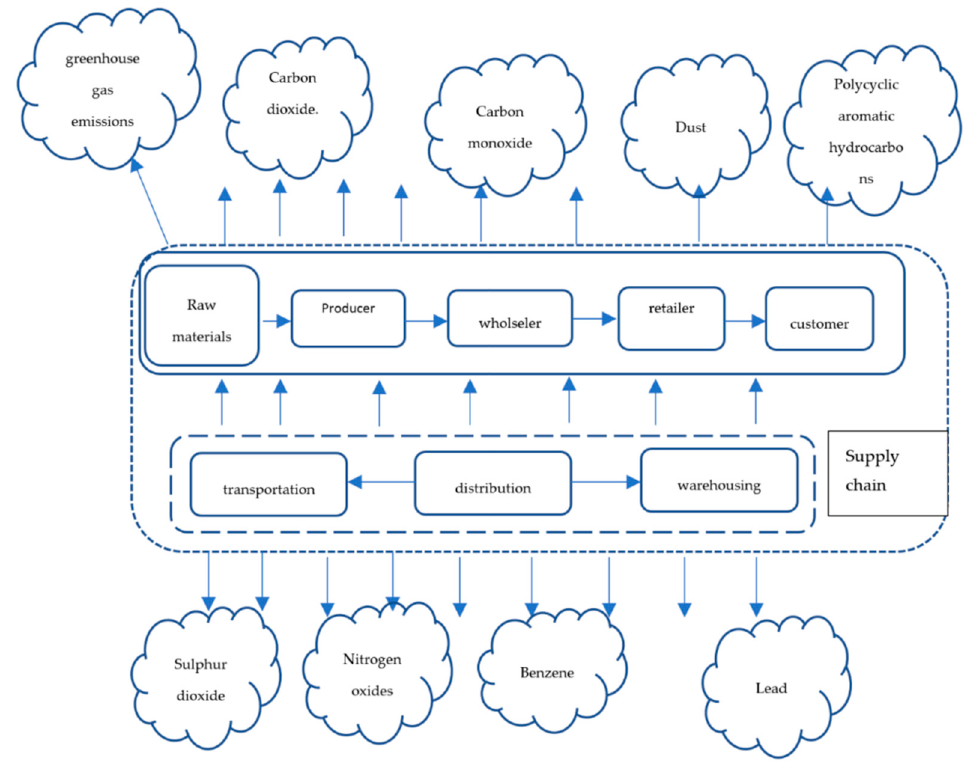
Figure 2. Framework of a simplified supply chain and its components responsible for greenhouse gas emissions. Source: own elaboration.